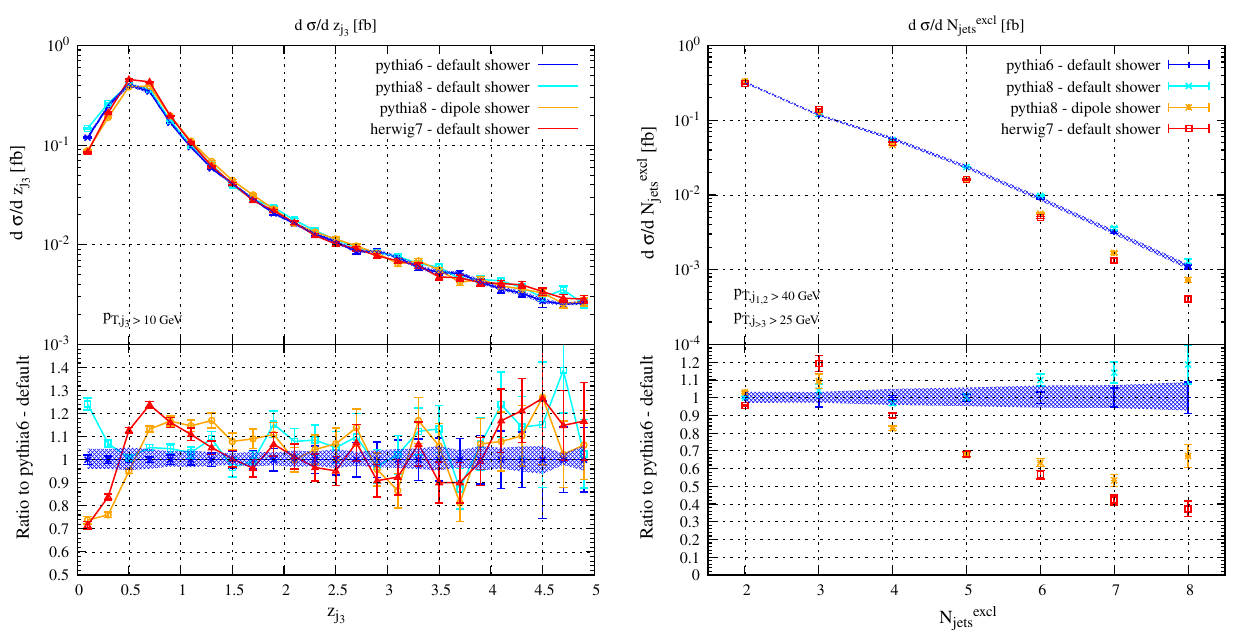
Fig. 9 Differential distribution of the Zeppenfeld variable defined in p T > 25 GeV. In the lower panel the ratio of the respective distribution Eq. (18) (left) and the number of exclusive jets (right) in the ATLAS- to the PYTHIA6 reference result is shown. In each case the blue bands > 10 GeV and in the loose scenario. In the left plot we require p T , j indicate the scale uncertainty of the PYTHIA6 simulations, statistical 3 uncertainties are denoted by error right plot we require all jets in addition to the two tag jets to have